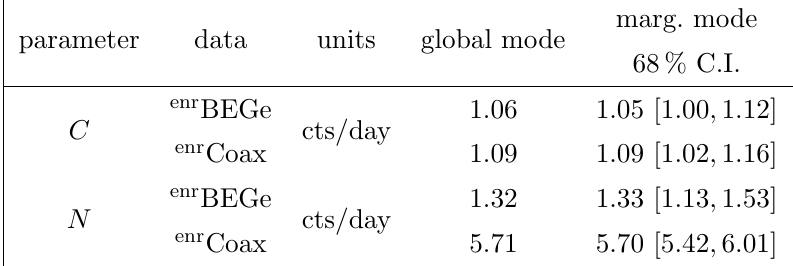
Table 9. Results of the (cid:11) events time distribution analysis in [3500 ; 5250] keV with a binning of 20 days for 27 enr BEGe and 7 enr Coax